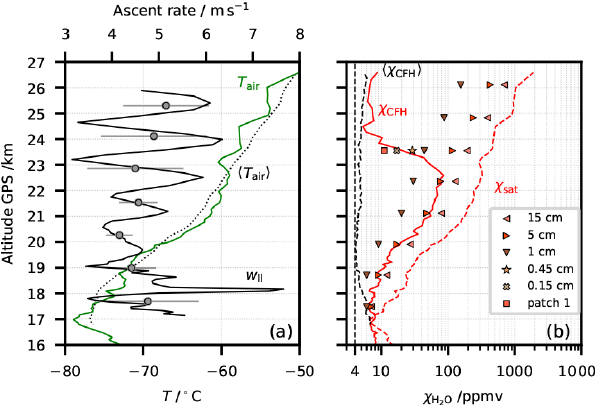
Figure 12. Flight NT011 and FLUENT simulation results for sublimation of ice in the intake tube in the stratosphere. (a) Green line: measured air temperature T air ; dotted black line: average air temperature for the 2016 Nainital summer campaign; solid black line: ascent velocity; circles: 1km interval-averaged ascent velocity; horizontal grey lines: standard deviation. (b) Solid red line: H 2 O mixing ratio measured by the CFH during NT011 ( χ CFH ); dashed black line: average H 2 O mixing ratio of the soundings during the 2016 Nainital summer campaign ( (cid:104) χ CFH (cid:105) ) (excluding the contaminated profiles); dashed red line: saturation H 2 O mixing ratio ( χ sat ); other symbols: FLUENT simulation results for the tube (cid:105) average mixing ratios (cid:104) χ H Vol in tubes with different ice-coating 2 O depths d coating the full circumference: (cid:74) d = 15cm; (cid:73) d = 5cm; (cid:72) d = 1cm; (cid:63) d = 0.45cm; x d = 0.15cm; coating only 1 / 8 intake tube circumference (patch): (cid:4) d = 1cm.